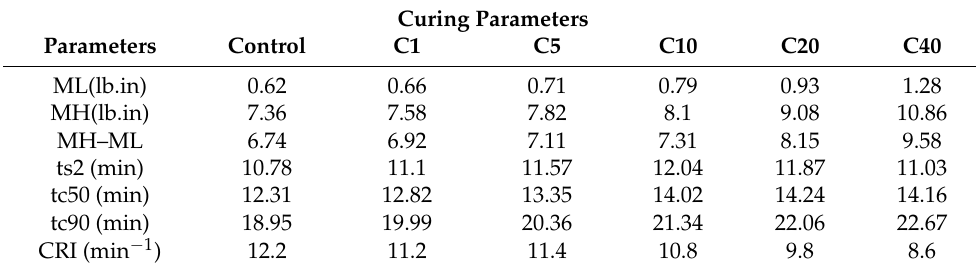
Table 3. Rheological properties of the composites.